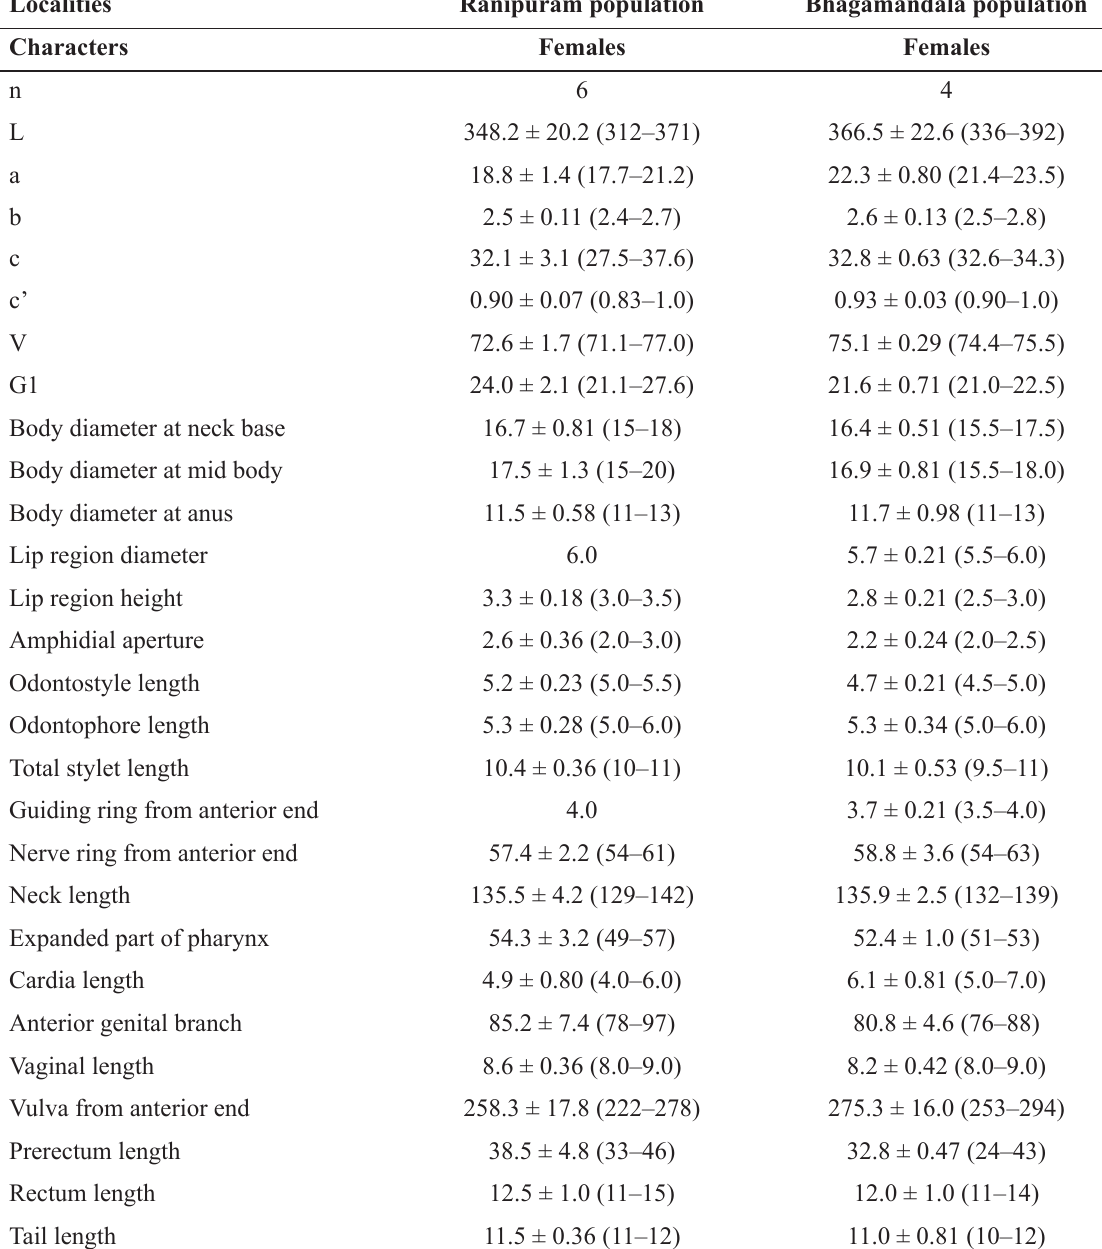
Table 3. Measurements of Tylencholaimus micronanus Yeates, 1979. All measurements are in µm and in the form: mean ± s.d.